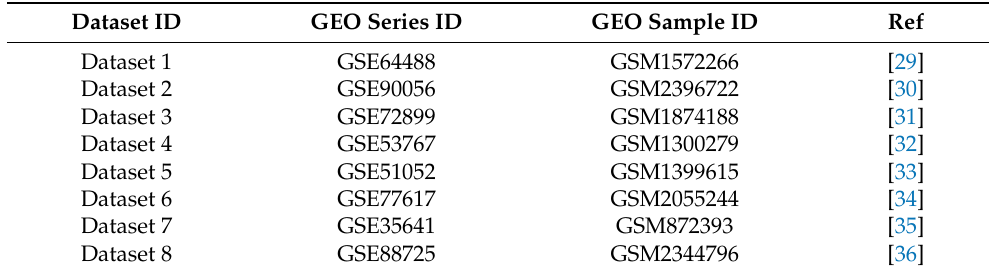
Table 1. The samples chosen for our analysis belong to different GEO series. Column 1: